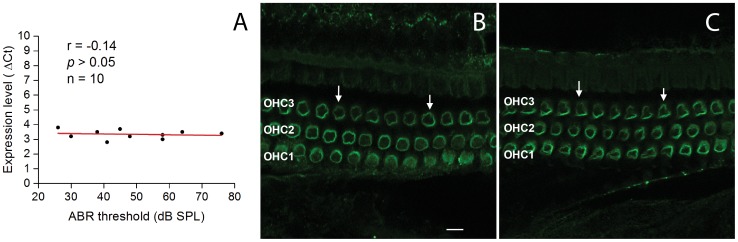
Prestin expression remains consistent in the Prestin-CreERT2 knockin homozygous mice showing diverse levels of hearing sensitivity.
A Correlation between the transcriptional expression levels of prestin and the ABR thresholds of the same ears in the Prestin-CreERT2 knockin homozygous mice. The total RNAs were extracted from the organ of Corti tissues, and the prestin mRNA expression level was normalized to the reference gene (Hprt1). There is no significant correlation between the level of prestin expression and the level of ABR threshold (Pearson's correlation analysis, r = −0.140, P = 0.699), indicating that the prestin expression level remains consistent among the ears with diverse threshold levels of ABRs. B A typical image of prestin immunoreactivity in the cochlear sensory epithelium of a wild-type mouse. The circular immunolabeling in the three rows of OHCs, indicated by the arrows, is clearly visible. OHC1, OHC2 and OHC3 indicate the first, second and third rows of OHCs, respectively. Bar  = 20 µm. C A typical image of prestin immunoreactivity in the cochlear sensory epithelium of a Prestin-CreERT2 knockin homozygous mouse that had a high level of the average ABR threshold (81 dB SPL). The pattern of prestin immunoreactivity is similar to that observed in the control ear (see Fig. 3B). Note that the fluorescence intensity of the prestin immunolabeling appears not be homogenous across certain OHCs in both (A) and (B), which is due to the off-focus of the confocal images.